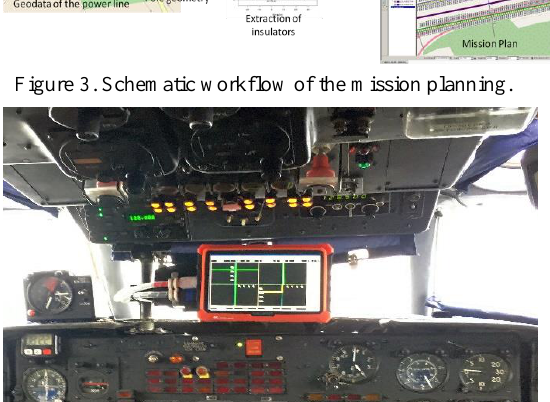
Figure 4. Pilot Screen with Navigation